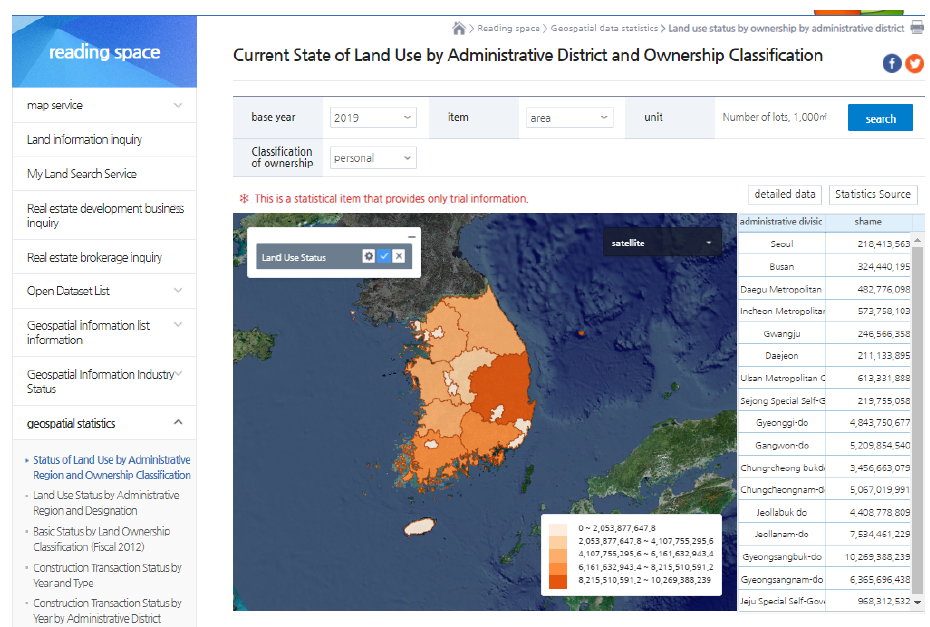
Figure 14. Visualization of spatial information statistics in 'reading space'.